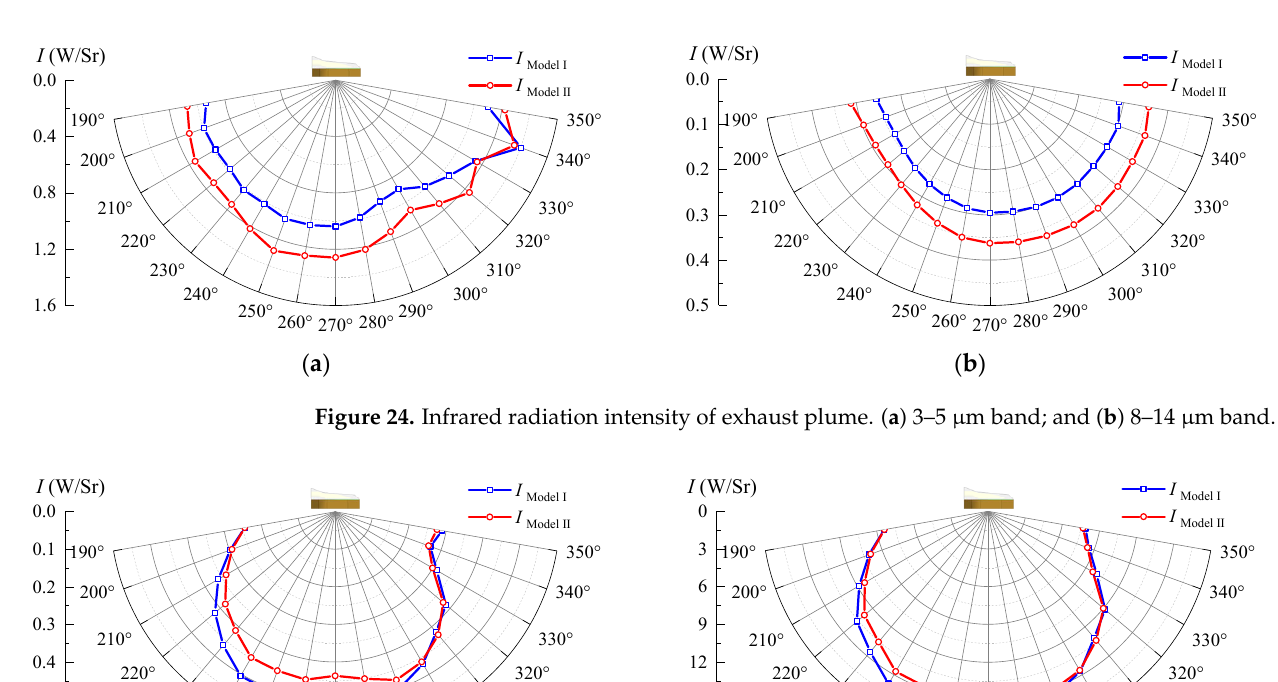
Figure 24. Infrared radiation intensity of exhaust plume. ( a ) 3–5 µm band; and ( b ) 8–14 µm band.